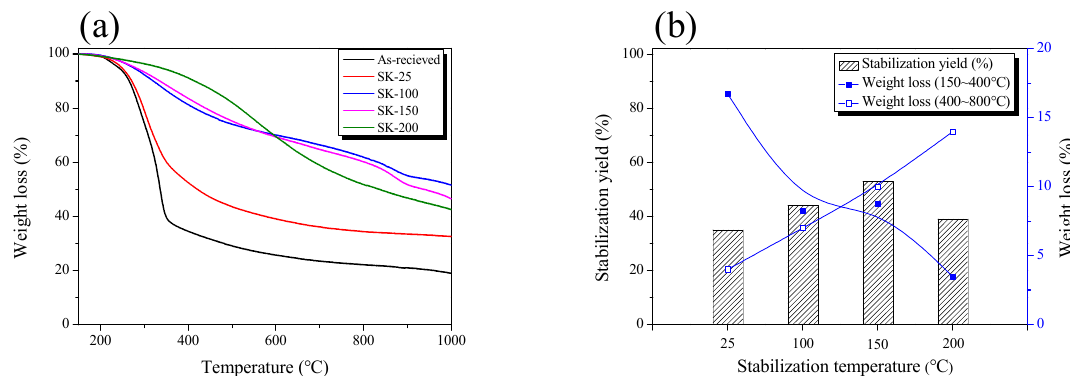
Figure 1. Thermal properties of stabilized kenaf: ( a ) Thermogravimetric analysis (TGA) curves; ( b ) weight loss.